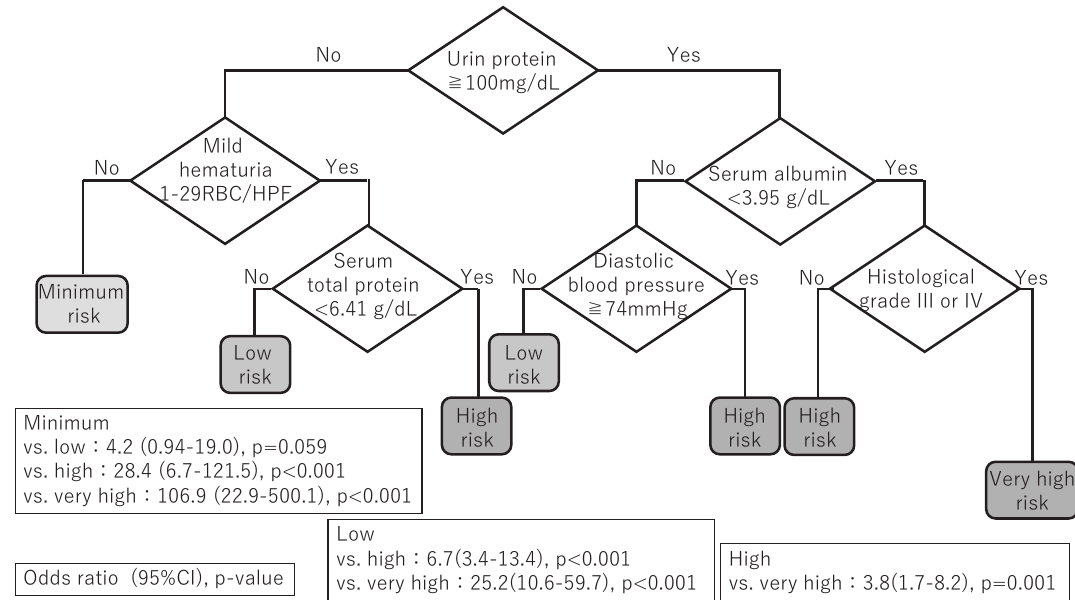
Fi g ure 1 Final decision tree